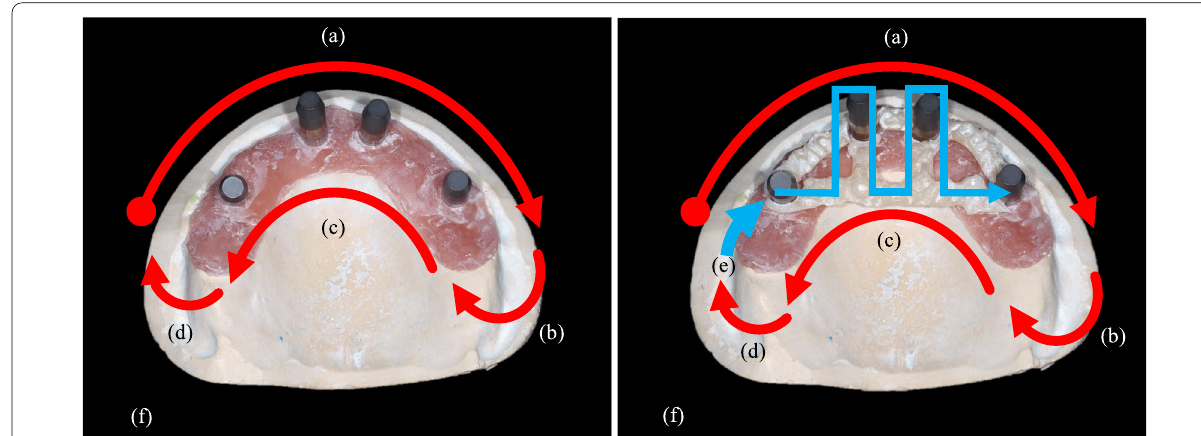
Fig. 2 Scanning path of intraoral scanners (IOSs) in each type of reference model. a Scanning path in Type 0, 1 b Scanning path in Type 2. a Scanning with IOS started from the bucco-occlusal surface of the scan body of #15. The bucco-occlusal surfaces were continuously scanned until the scan body of #25. b Posterior to the scan body of #25, the scanner was turned from the buccal side to the palatal side. c From the scan body of #25, the palatal and occlusal surfaces were scanned continuously until scan body #15. d Posterior to the scan body of #15, the scanner was turned from the palatal to the buccal side. e The branches of the assisting device on the palate were scanned continuously. f A rescan was performed to complement the missing dataset of the first